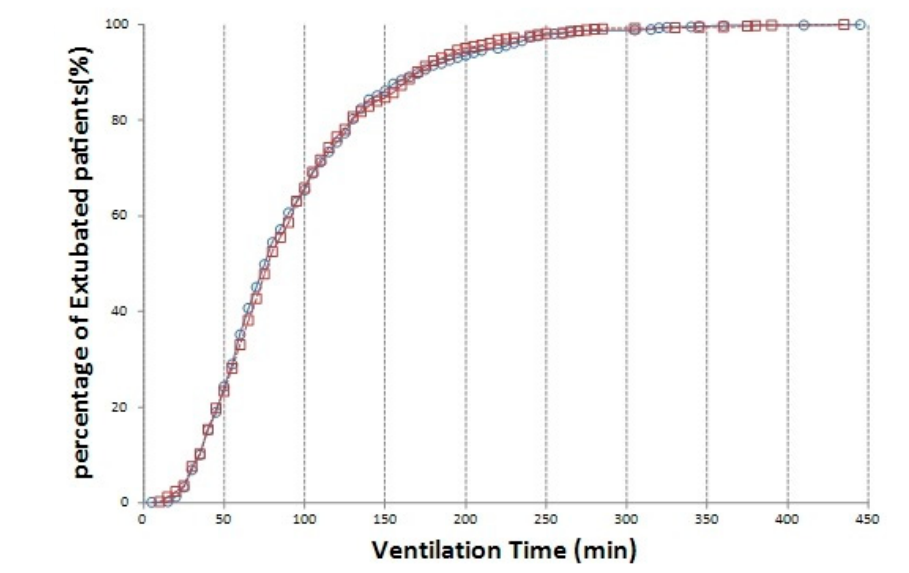
The duration of mechanical ventilation was not significantly different between the groups (Figure 3).